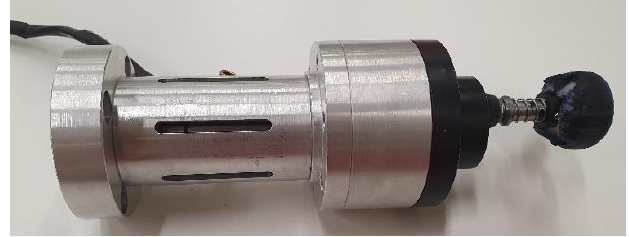
Figure 12. Prototype of the polishing tool.